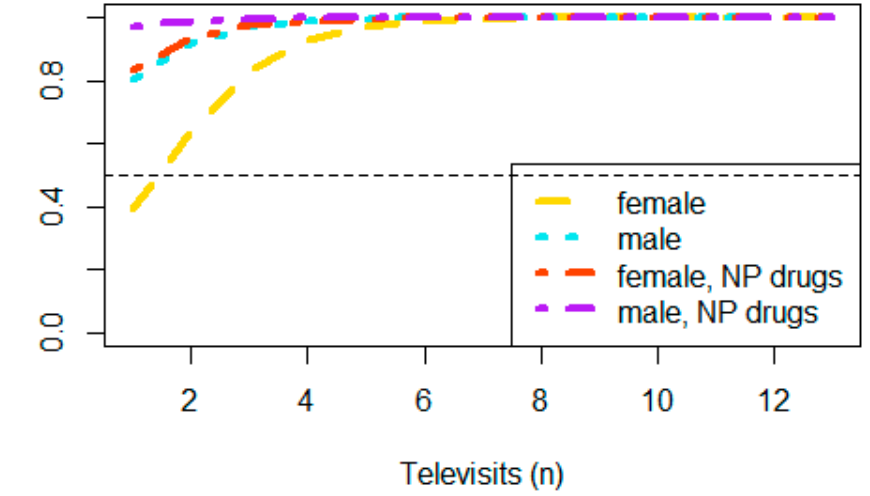
Figure 2. Probability of in-person visit. The probability of dropout ( p ) increased as the number of visits increased and especially in male patients who were treated with drugs for neuropathic pain (e.g., anticonvulsants and antidepressants). Abbreviations: NP, neuropathic pain.